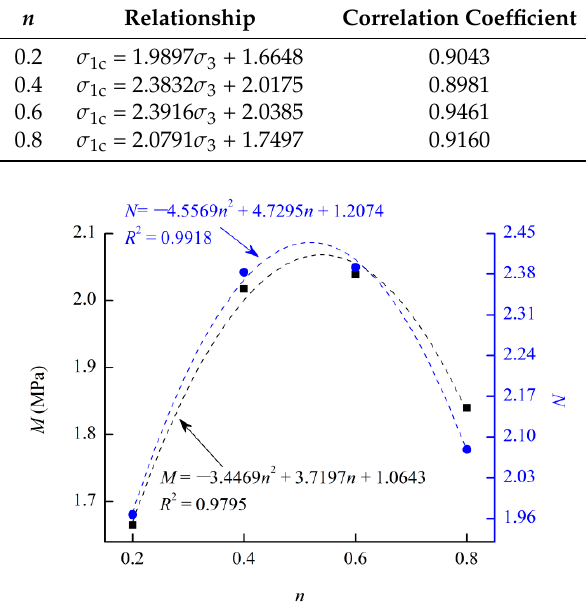
Figure 11. Relationship between the fitting strength parameter and Talbot index of CPB specimens.